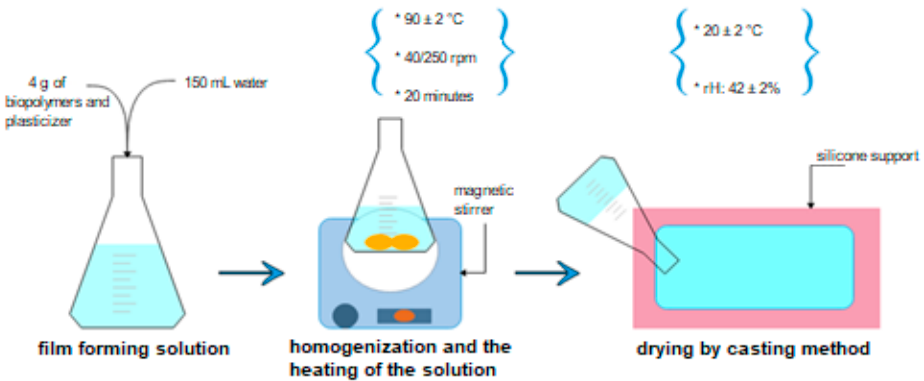
Figure 1. Graphic representation of films’ development.